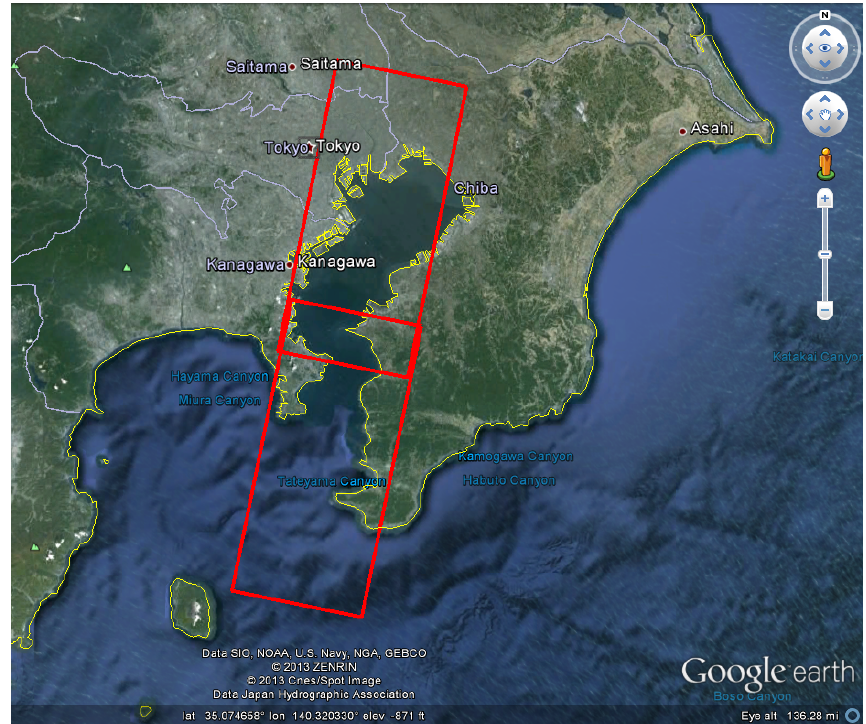
Figure 4. Location (red polygons) of the quad-polarimetric ALOS-PALSAR data. Google